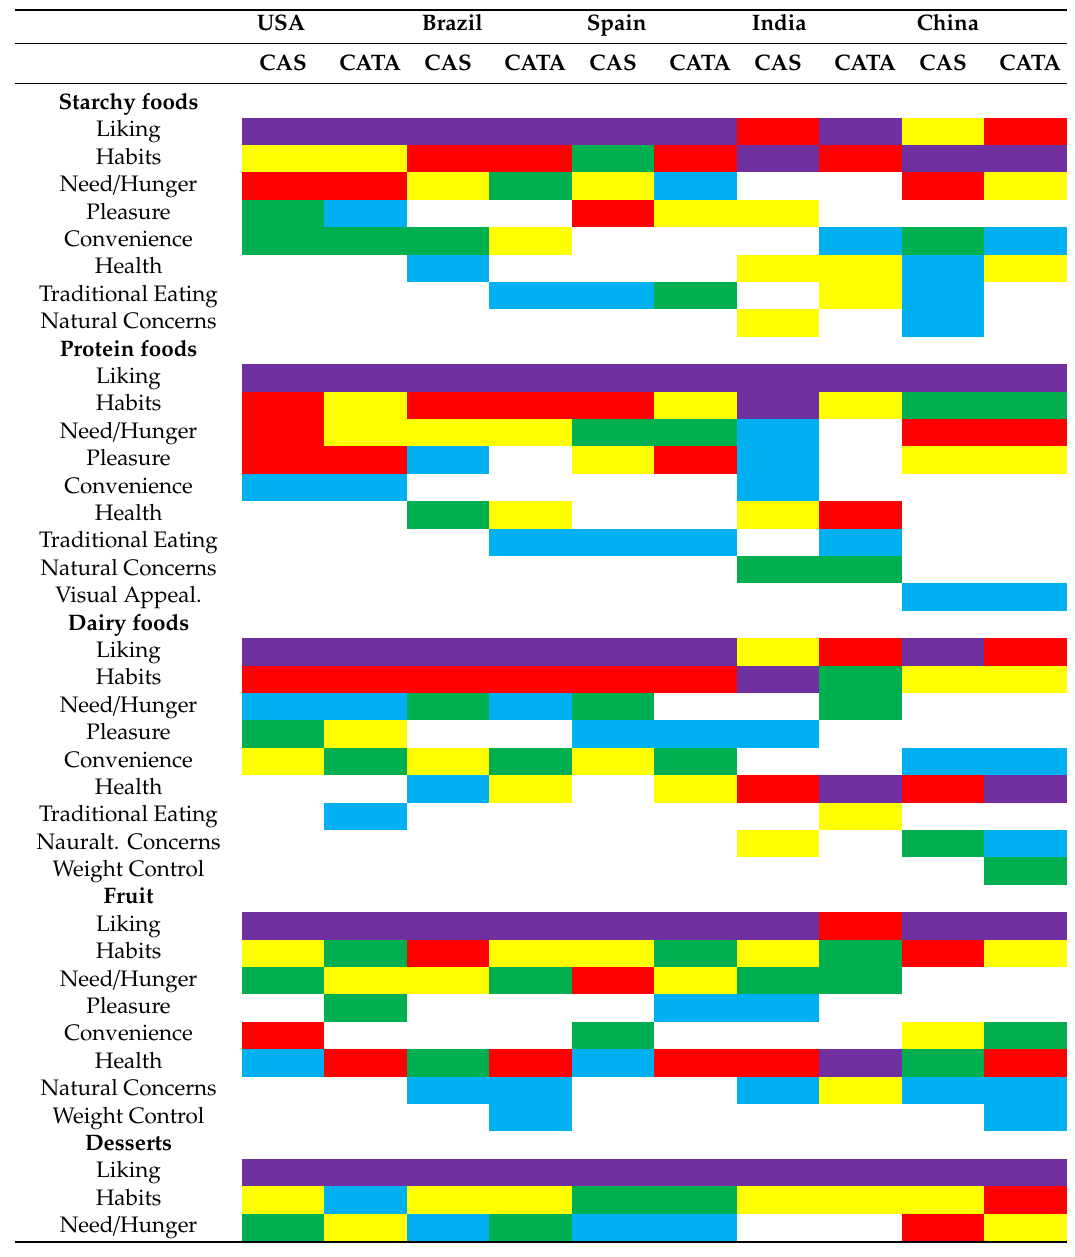
Table 6. Rank of the top five motivation constructs based on percentages within each food group and each country for both CAS and CATA 1